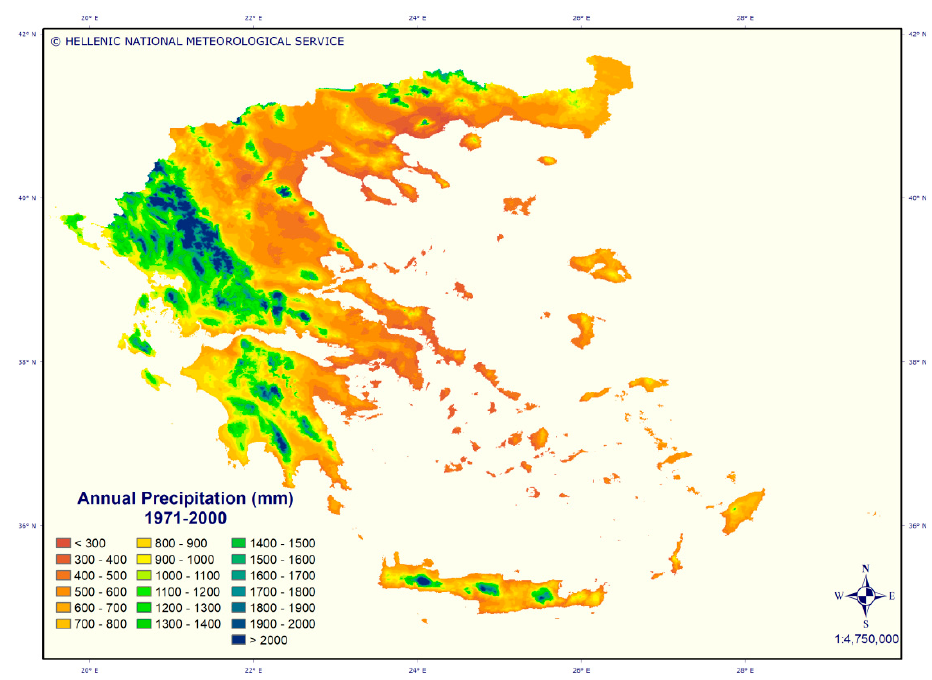
Figure 9. Annual precipitation map for the period 1971–2000.